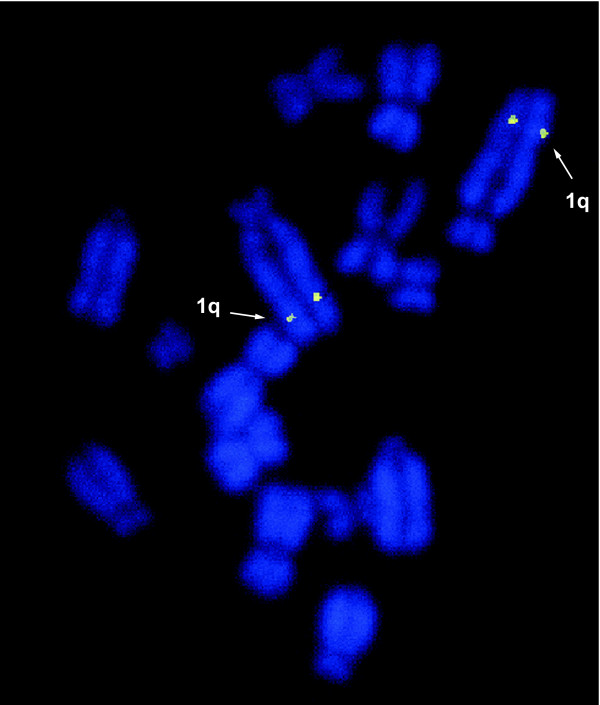
Localisation of the tammarELPgene toMacropus eugeniichromosome 1q using FISH.